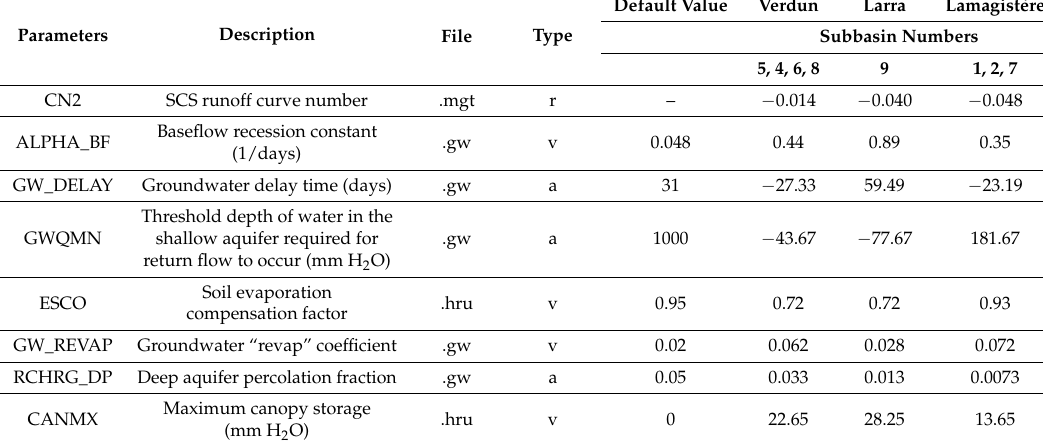
Table 4. Automatically calibrated parameters. Types of parameters: r, relative (the existing parameter value is multiplied by (1 + a given value)); a, absolute (the given value is added to the existing parameter value); v, replace (the existing parameter value is replaced by the given value). – for the default value means default value is not unique; – for the value of subbasins means retain the default